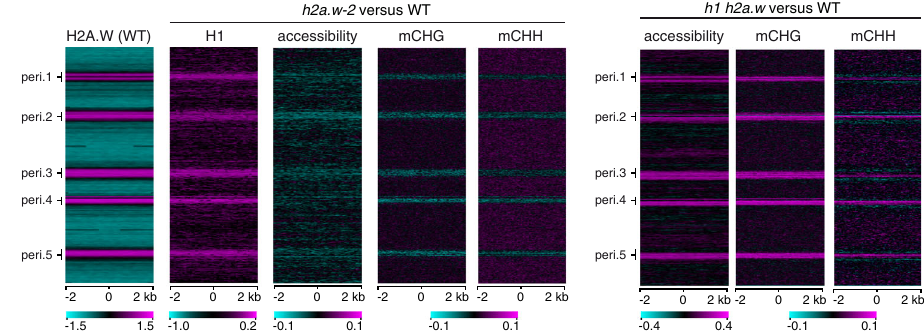
Fig. 8 h2a.w-2 and h1 h2a.w show opposite changes in accessibility and non-CG methylation. The genome was divided into consecutive, non-overlapping 4-kb bins, which are stacked according to their genomic position from the top of chromosome 1 to the bottom of chromosome 5. Pericentromeric regions are indicated (peri.1 to peri.5). H2A.W enrichment in the WT (log2 ChIP/H3) is shown as a heat map on the left. Other heat maps show changes in H1 levels ( h2a.w-2/ WT; log2 ChIP/H3), changes in chromatin accessibility (log2 mutant / WT; ATAC-seq read depth), and changes in CHG and CHH DNA methylation (mutant minus WT) in h2a.w-2 versus WT and in h1 h2a.w versus WT.